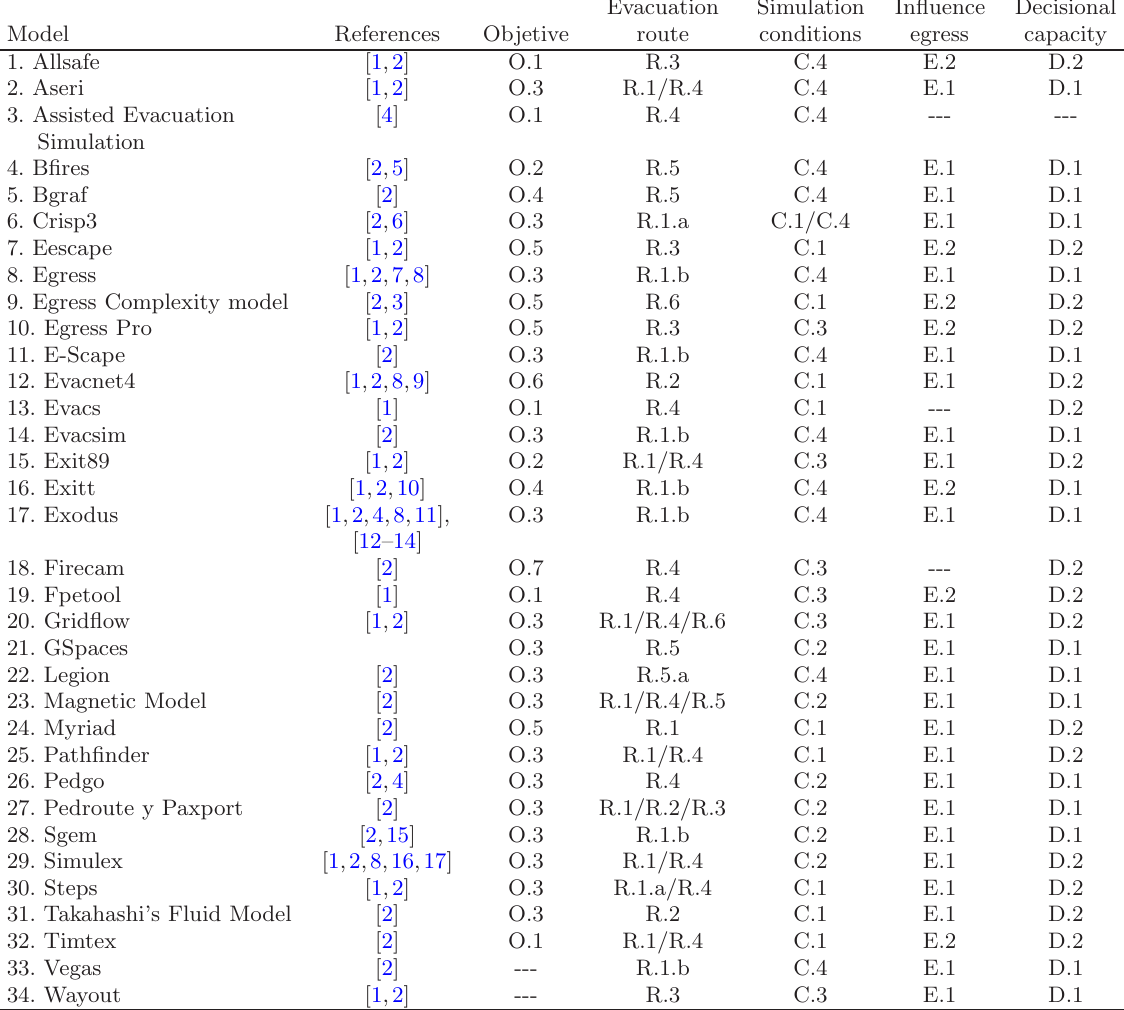
Table 1. Summary of the features of the reviewed evacuation